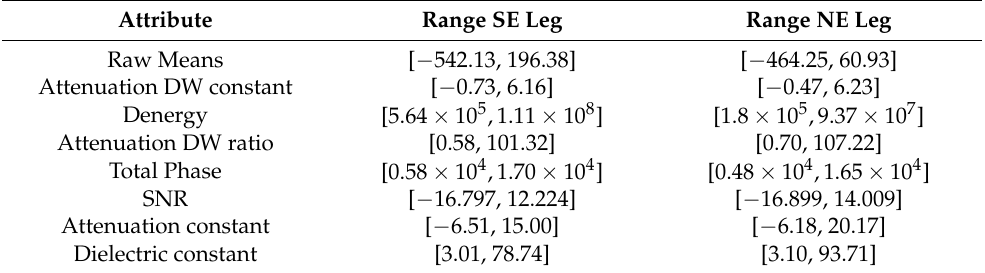
Figure 12. Attributes unsuccessful in capturing differences between the construction phases. For a more quantitative comparison, the range of measured values for the two different legs are shown in Table 3. Table 3. Range of values for various measured attributes in the southeast and northeast